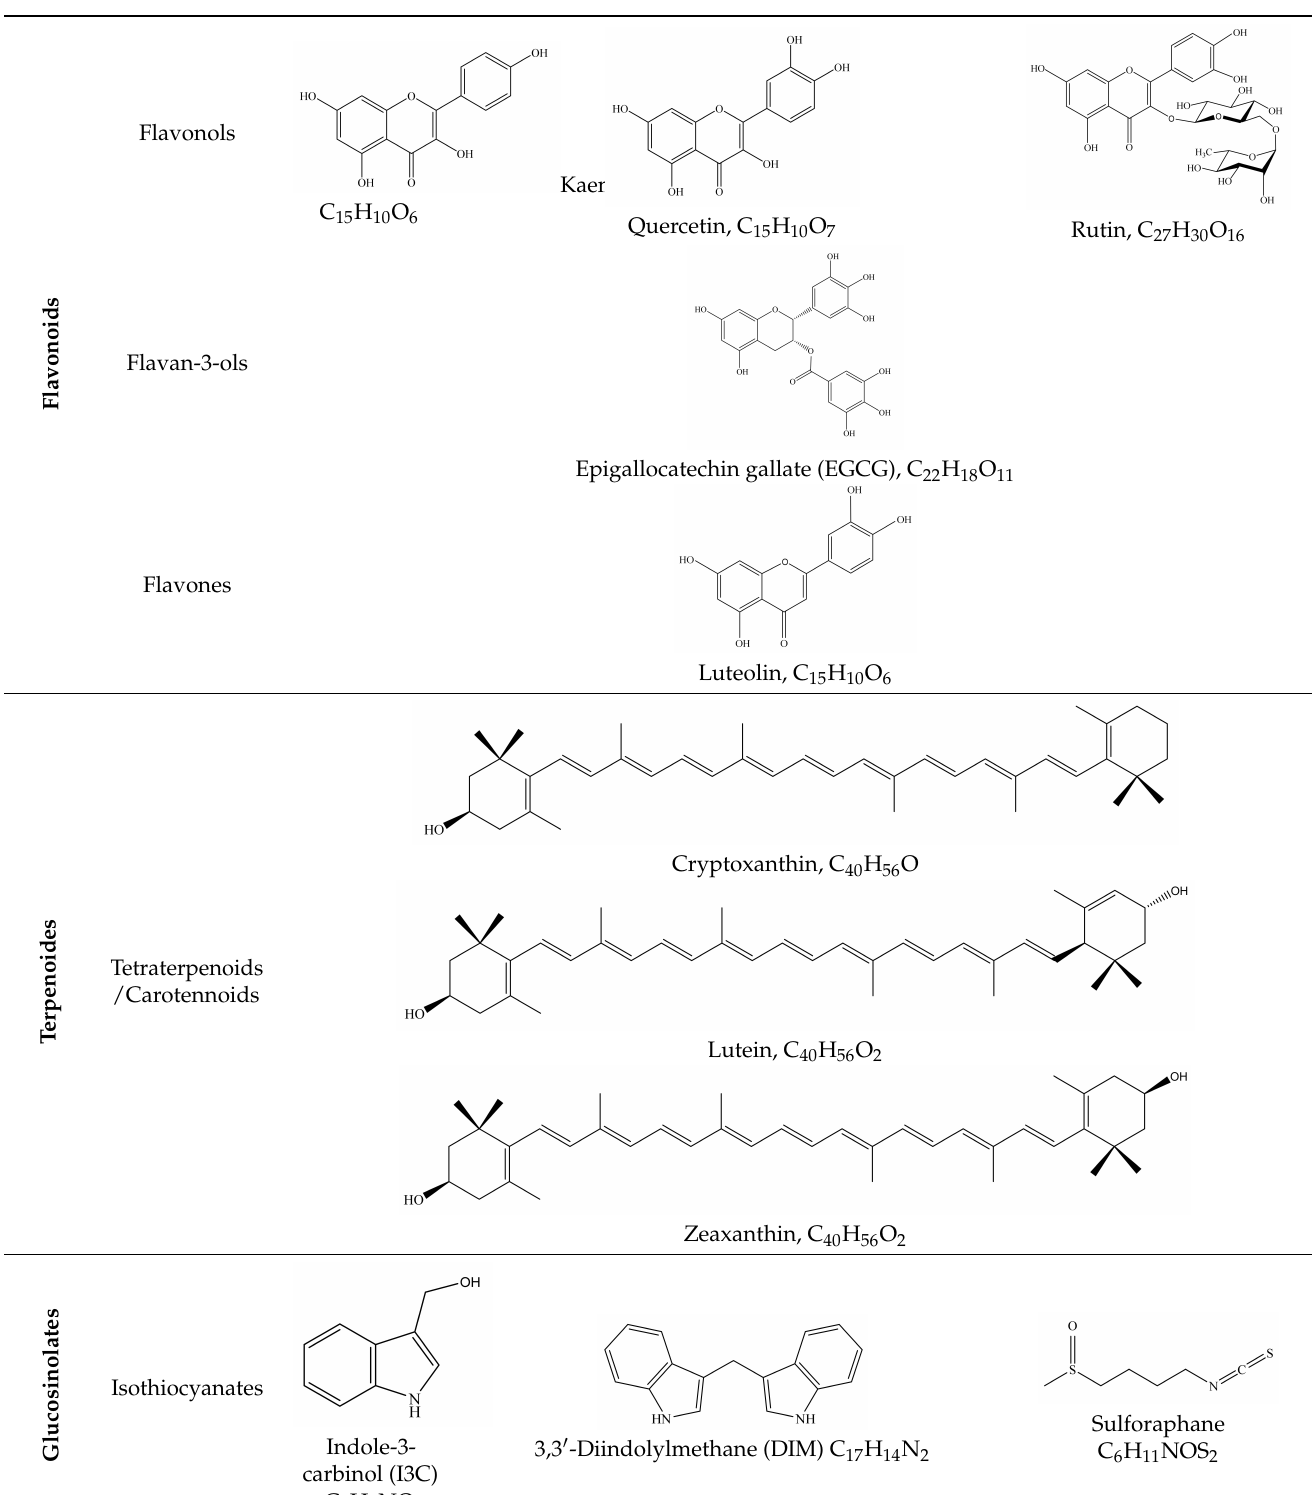
Table 2. The chemical structure of bioactive